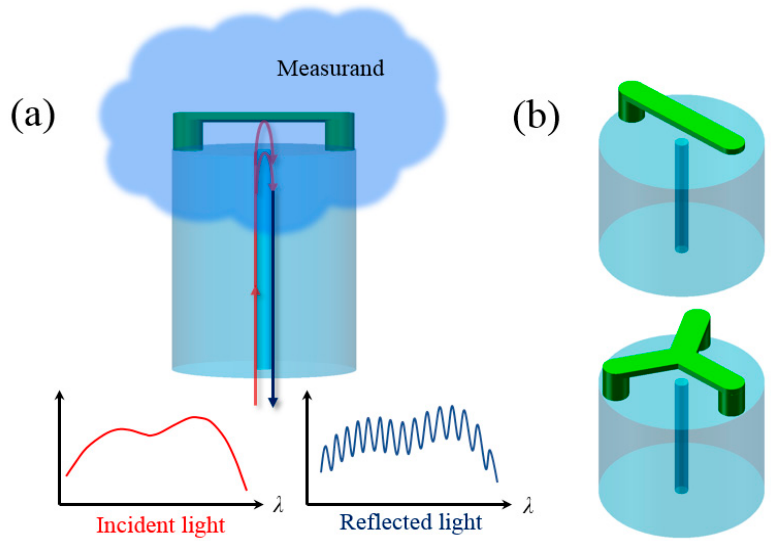
Figure 1. ( a ) Schematic of an optical fiber-tip sensor and its working principle. ( b ) Schematics of the other two optical fiber-tip sensors with different structures of suspended microbeams.